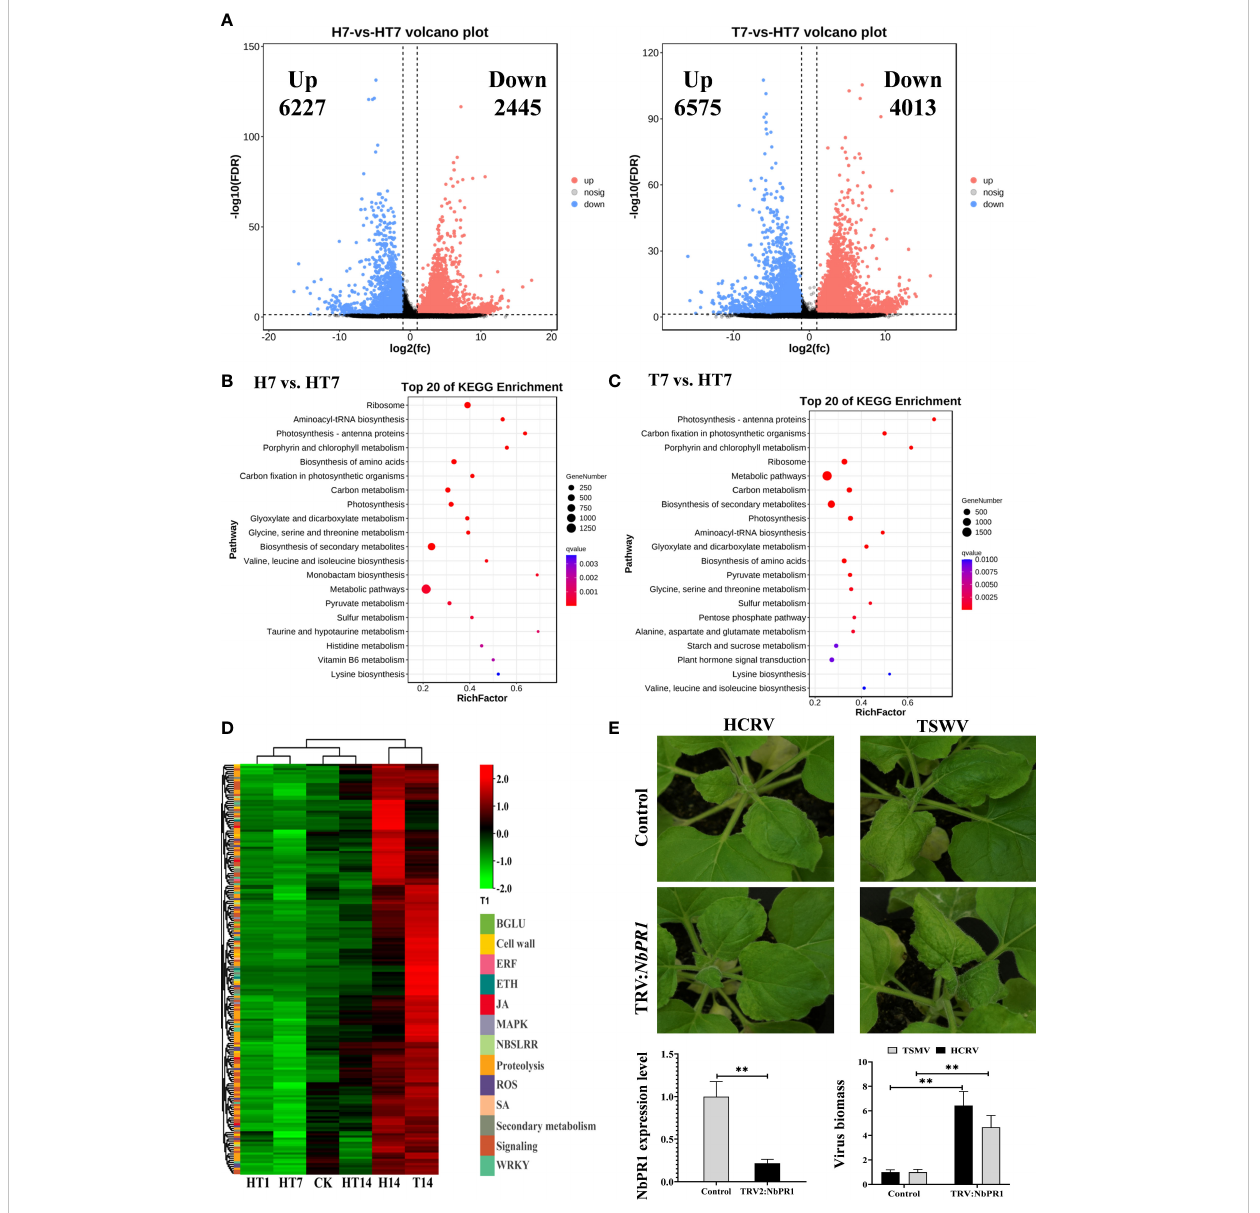
FIGURE 5 TH complex infection dramatically suppressed the genes relevant to plant resistance to biotic stress. (A) Volcano plots display the pattern of expression of Nicotiana benthamiana in TH vs. H (left) and TH vs. T (right) at 7 days post-inoculation. (B) Scatter plot of the enriched TOP 20 KEGG pathways for the DEGs of N. benthamiana at 7 days post-inoculation of the TH complex. (C) KEGG pathway enrichment in TH7 vs. T7 comparison. (D) A heat map showing the expression of genes relevant to plant resistance in N. benthamiana following the H virus, T virus, and TH complex challenges. The color intensity displayed in the heatmap is the mean TPM value of each gene and is used to exhibit the gene expression level. (E) Silencing of NbPR1 results in a loss of resistance in tobacco to HCRV and TSWV. The silencing ef fi ciency of NbPR1 in tobacco through the VIGS system is detected using RT-qPCR. The biomass of both HCRV and TSWV in tobacco with NbPR1 silencing is detected using RT-qPCR. ** P <